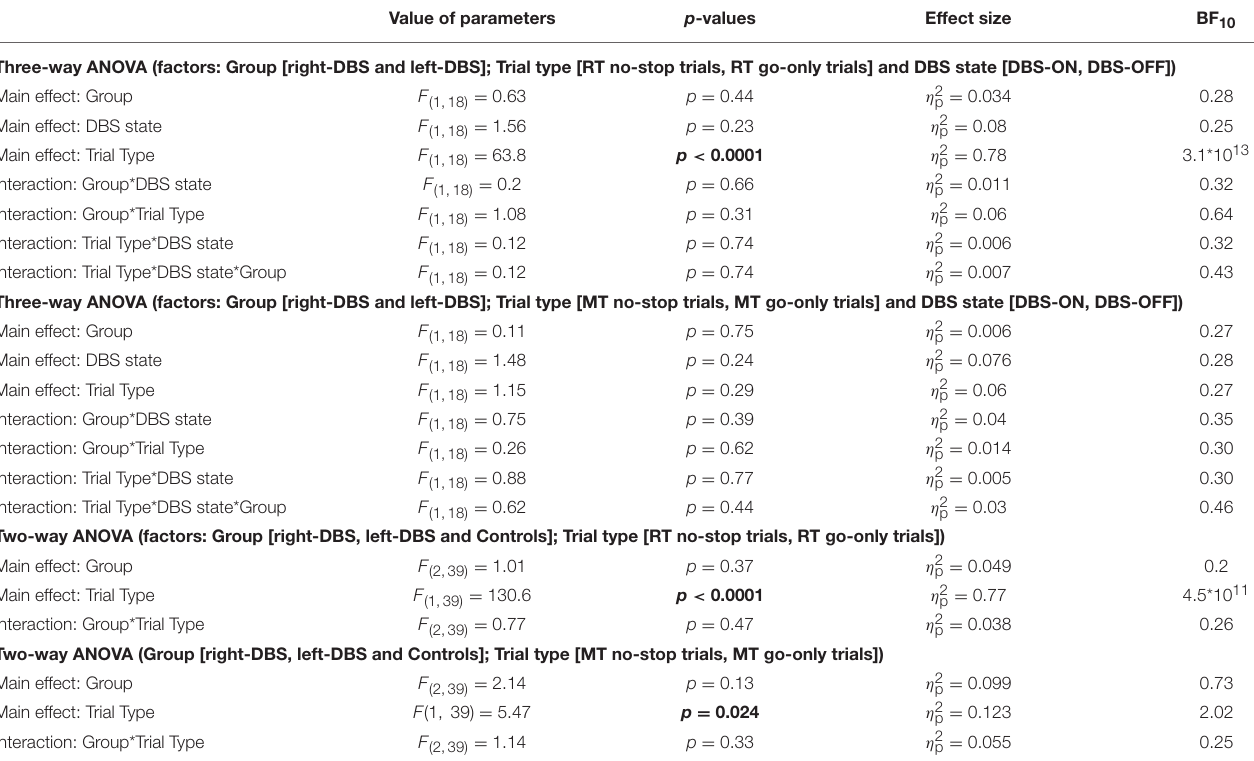
TABLE 5 | Results of the statistical analysis of mean RTs and MTs across right-DBS patients, left-DBS patients, and age-matched controls. Value of parameters p -values Effect size BF